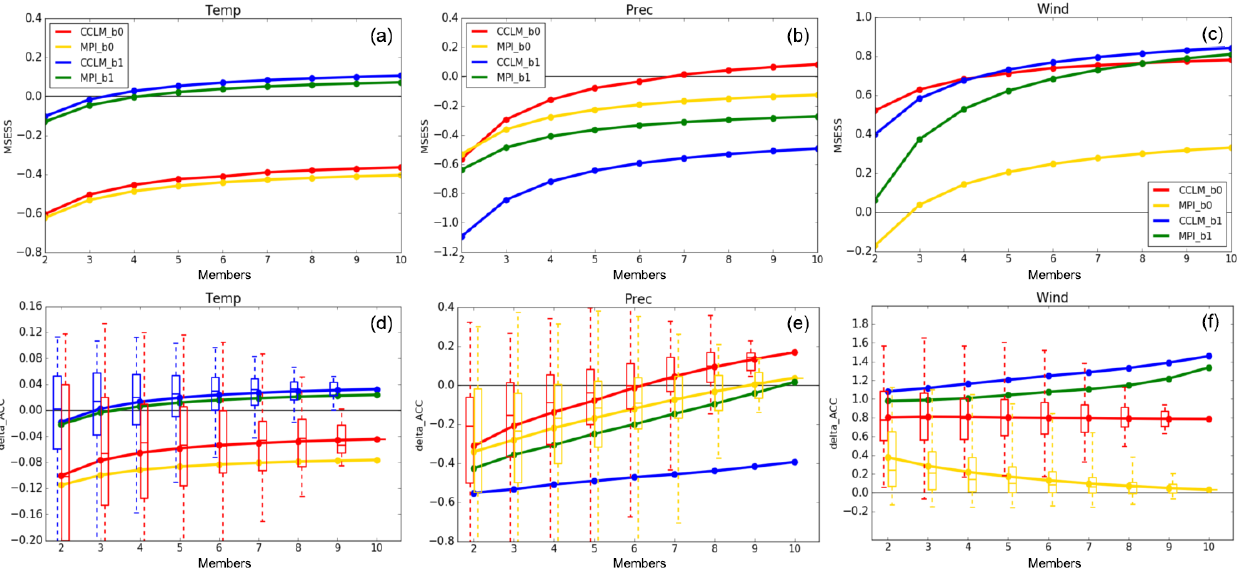
Figure 5. Skill scores for the multi-annual mean anomalies of lead years 1–5 of the CCLM_b0 (red), MPI_b0 (yellow), CCLM_b1 (blue), and MPI_b1 (green) ensembles depending on the ensemble size ( x axis, ranging from 2 to 10 members) over IP (cf. Fig. 1). MSESS for (a) temperature, (b) precipitation, and (c) wind speed; delta_ACC for (d) temperature, (e) precipitation, and (f) wind speed. In (d) – (f) box and whisker plots for the skill scores of all n -member combinations are shown to indicate the uncertainty due to the ensemble size. For MSESS and delta_ACC we have used the uninitialized historical ensemble as reference dataset. Note the different scaling of the y axis. For details, please refer to the main